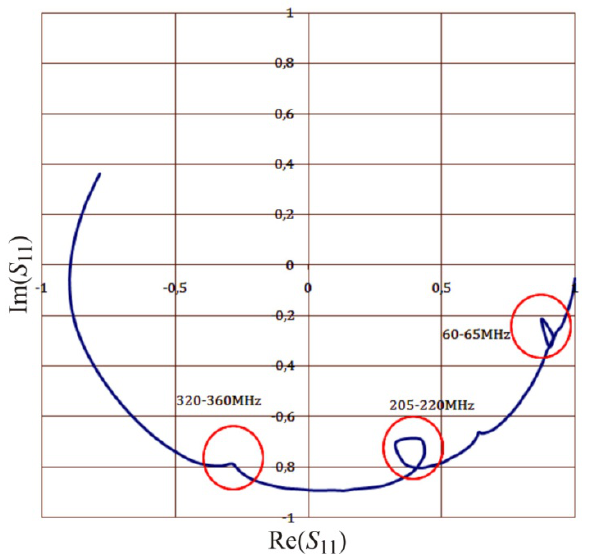
parameter measured by 11